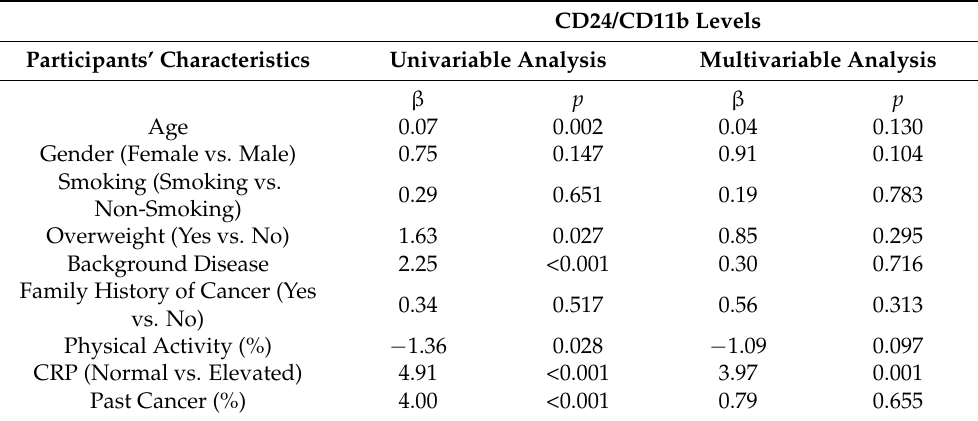
Table 3. Association between participants’ characteristics and CD24 levels for univariate and multi- variate